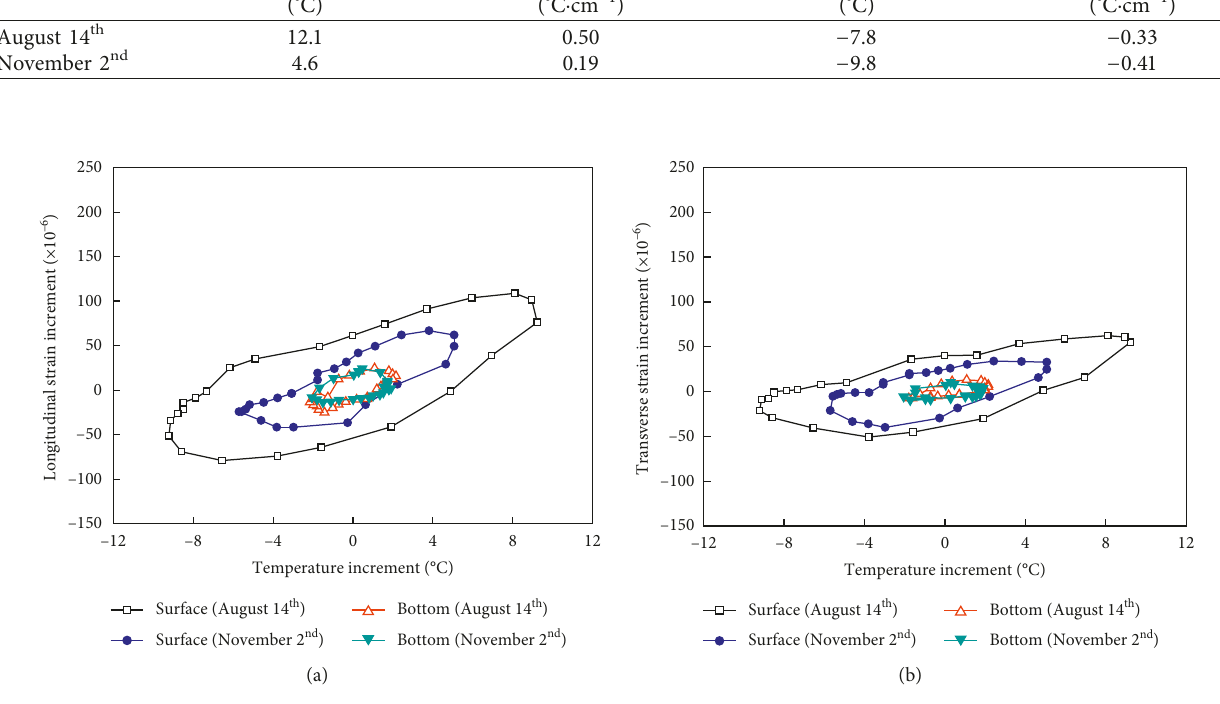
Figure 4: Relationships between the measured temperature-strain increments. (a) Longitudinal temperature-strain increments. (b) Transverse temperature-strain